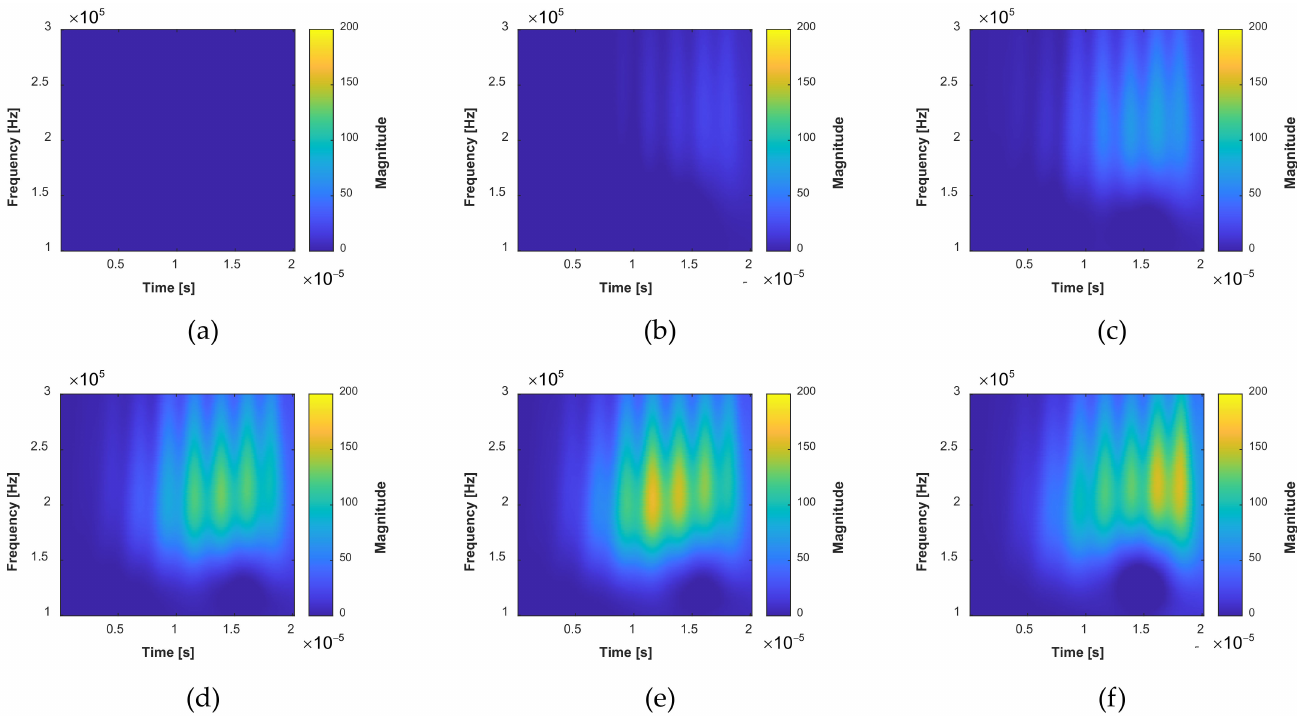
Figure 11. Extracted differential TFS images with the fatigue crack growth in specimen D1: ( a ) The total crack length is 0 mm obtained by the continuous wavelet transform; ( b ) The total crack length is 4.2 mm; ( c ) The total crack length is 9.5 mm; ( d ) The total crack length is 16 mm; ( e ) The total crack length is 22 mm; ( f ) The total crack length is 32